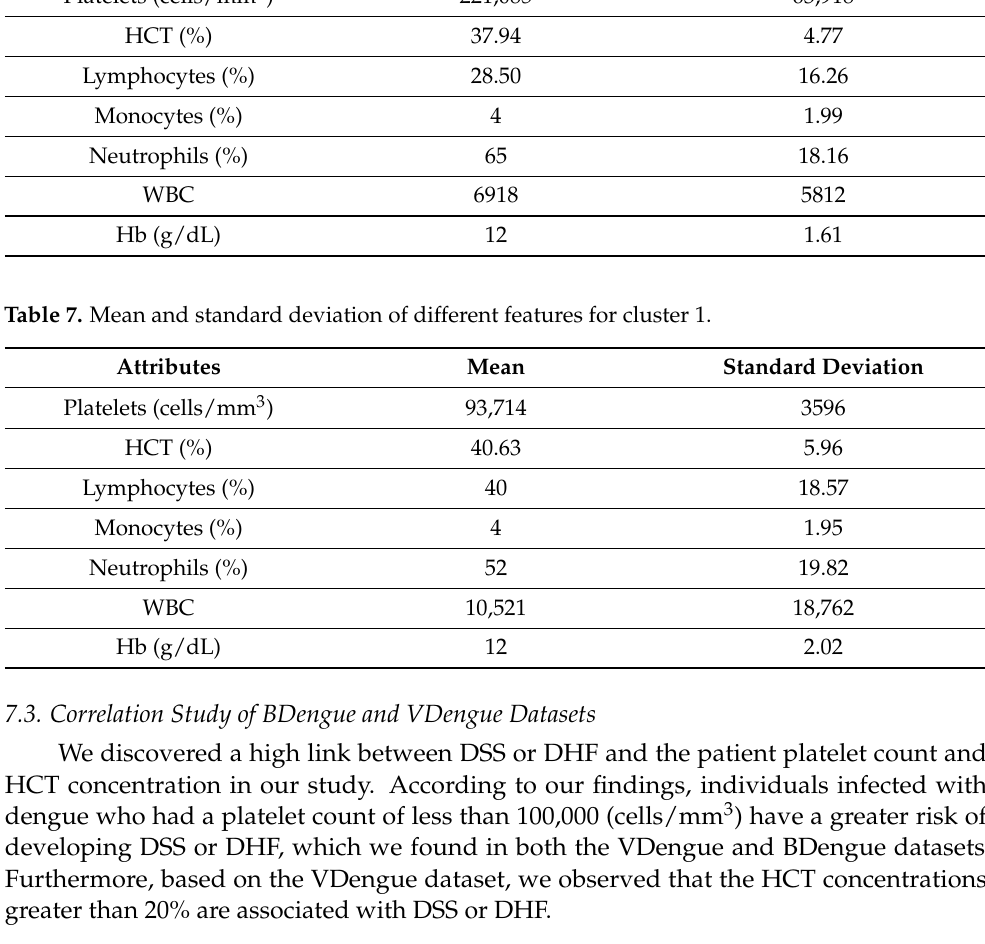
Table 6. Mean and standard deviation of different features for cluster 0. Attributes